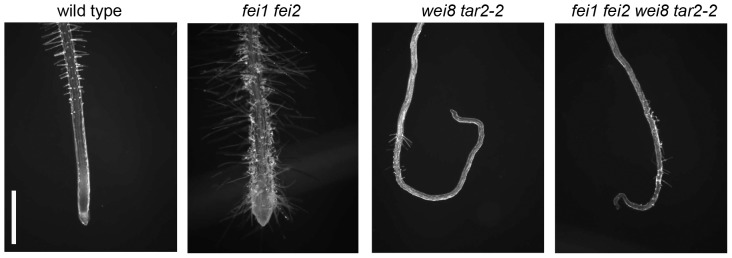
Mutations in the auxin biosynthetic genes WEI8 and TAR2 suppress fei1 fei2.Phenotypes of the root tips of the indicated seedlings four days after transfer from MS medium containing 0% sucrose to MS medium containing 4.5% sucrose. Scale bar = 1 mm.